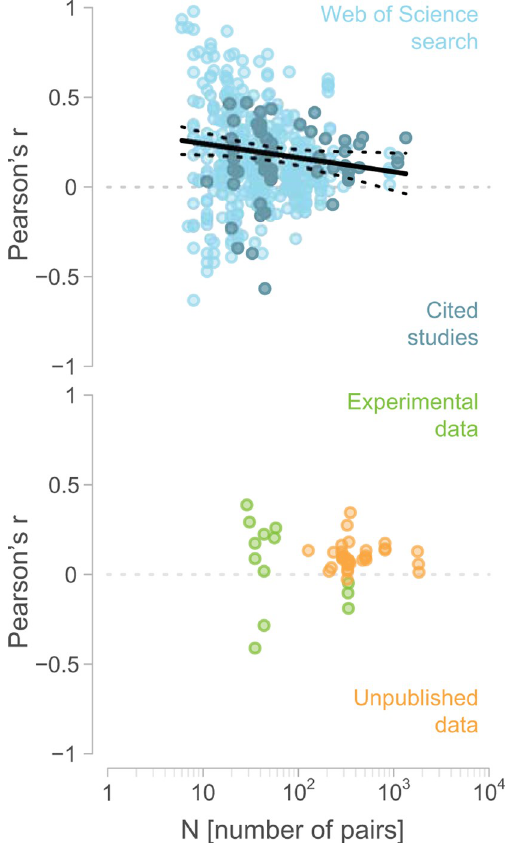
Fig 2. Strength of assortative mating for body size in relation to sample size. Each dot represents a single estimate of assortative mating for a phenotypic trait, its colour the type of estimate (light blue, Web of Science search; dark blue, Cited studies; green, Experimental data; orange, previously Unpublished data). The black regression line refers to all published estimates (Web of Science search plus Cited studies), and dashed lines indicate the 95% CI. Underlying data can be found in S7